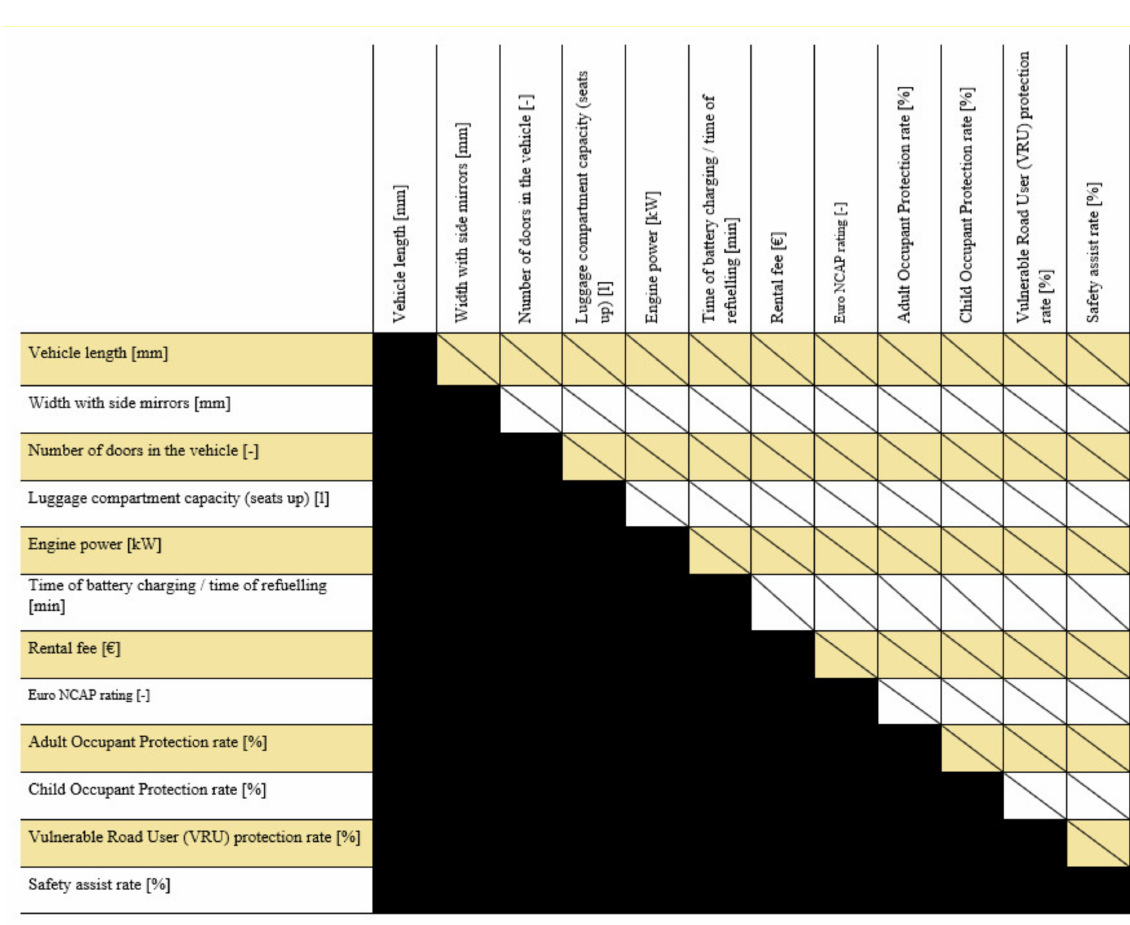
Figure 2. Pairwise factor comparison questionnaire.